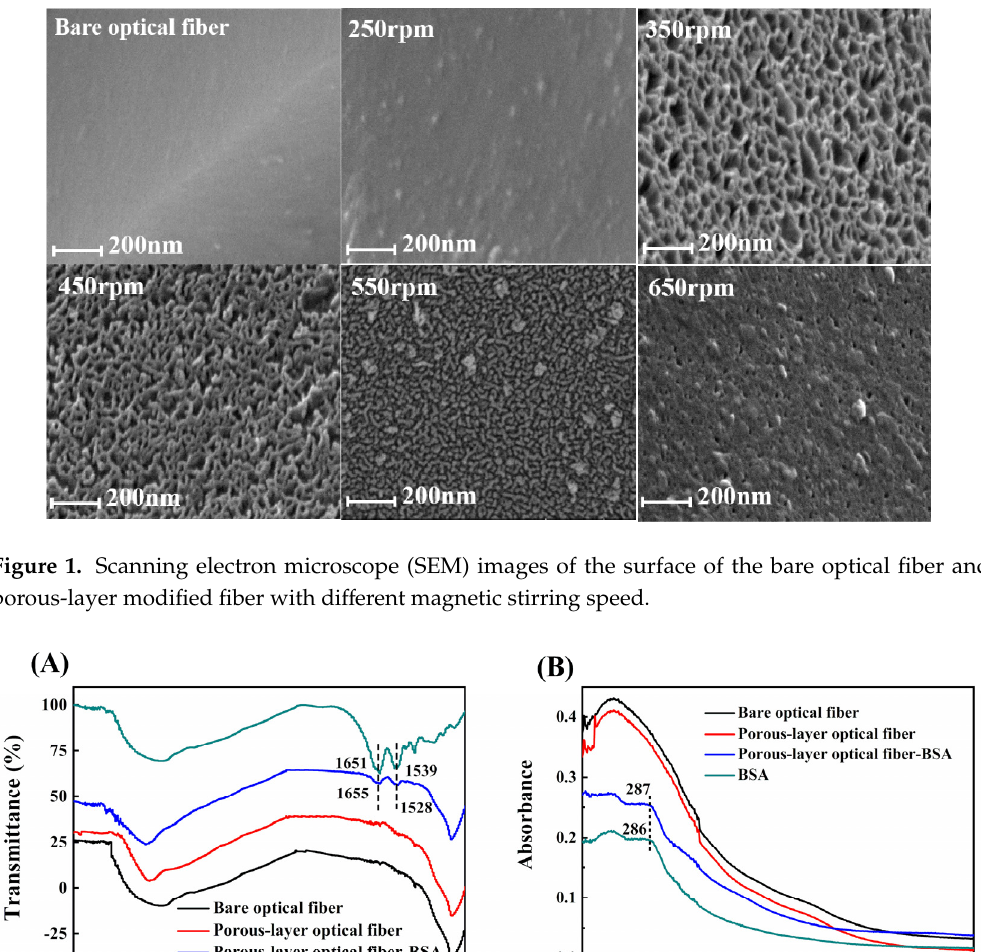
Figure 1. Scanning electron microscope (SEM) images of the surface of the bare optical fiber and porous-layer modified fiber with different magnetic stirring speed.